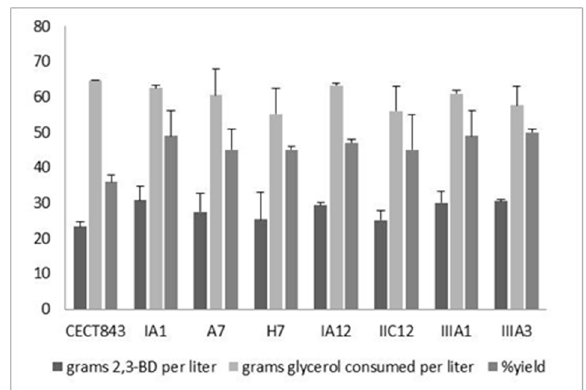
Figure 3. Second round of comparisons between wild type and selected mutants at bioreactor scale. Strains A7, H7, IA1, IA12, IIC12, IIIA1 and IIIA3 were tested in 1.5 L bioreactors with medium MB